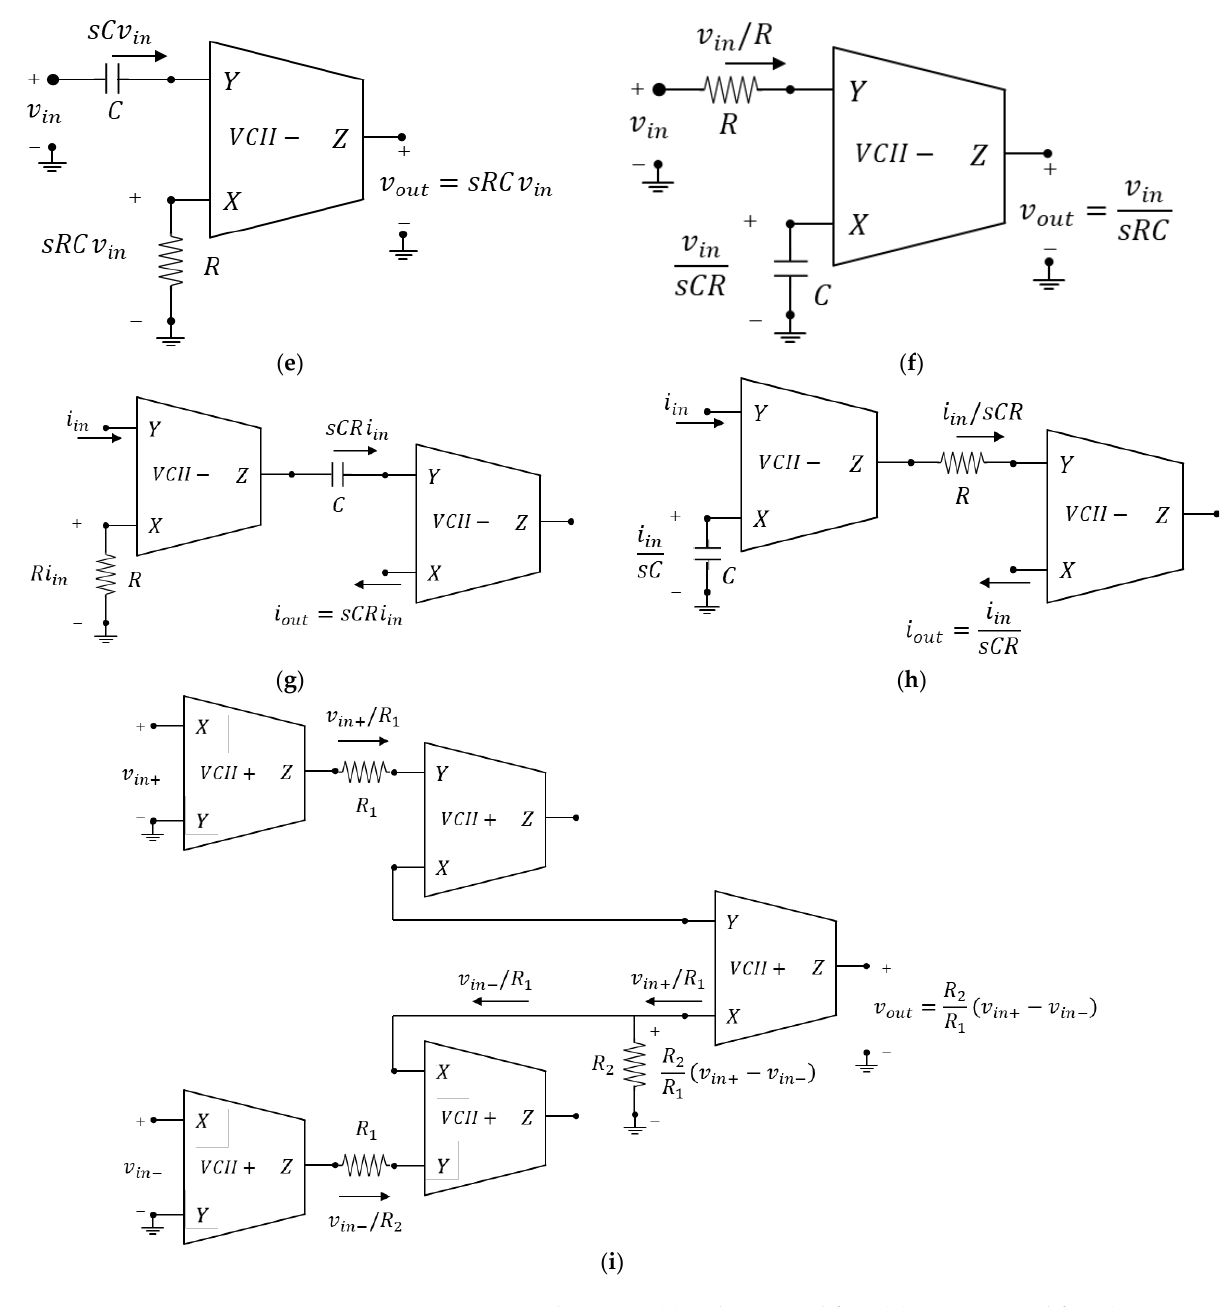
Figure 6. Basic VCII applications: ( a ) voltage amplifier; ( b ) current amplifier; ( c ) V-I converter; ( d ) I-V converter; ( e ) voltage differentiator; ( f ) voltage integrator; ( g ) current differentiator; ( h ) current integrator; ( i ) differential voltage amplifier.